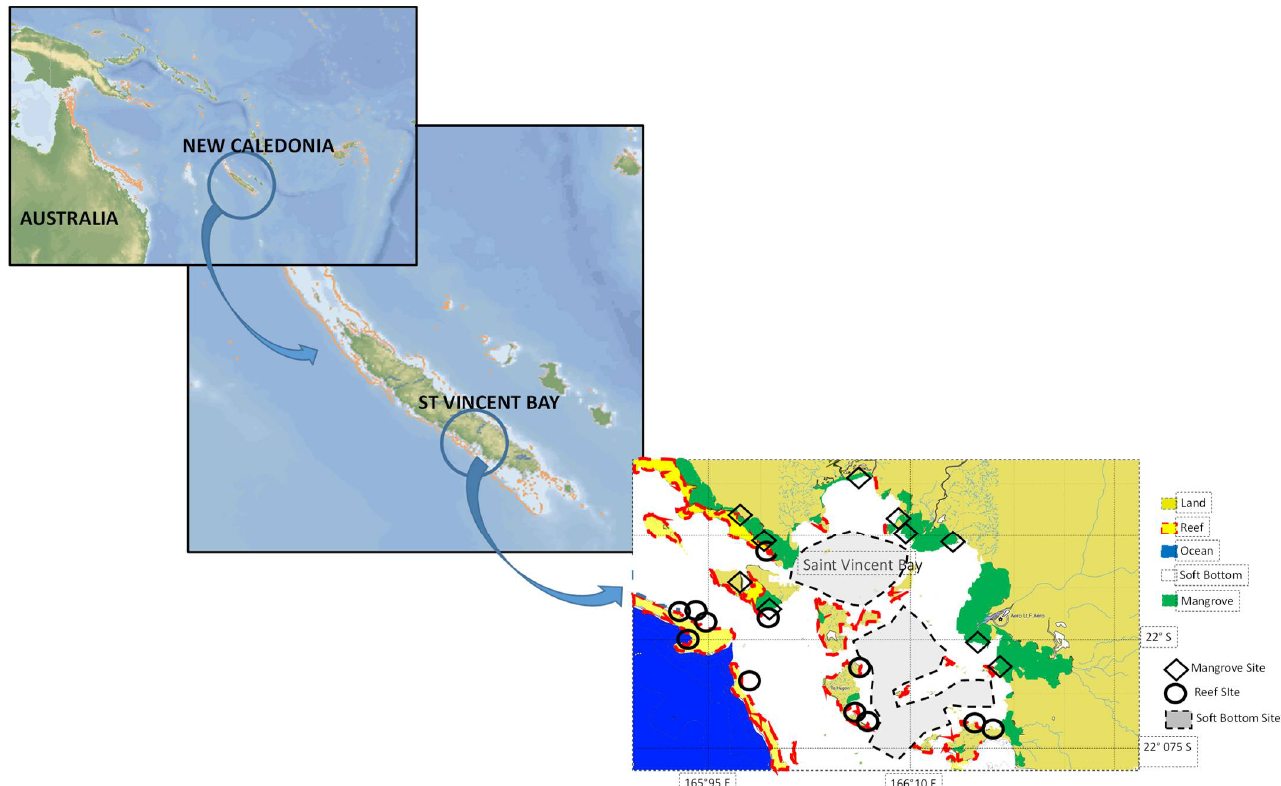
Figure 1. Map of the sampling area. Reef: zones with 100% hard bottom, mainly constructed coral reef. Mangroves comprise several types of mangroves (see Supplementary Materials Table S1). Soft- bottoms include seagrass and macroalgal beds.